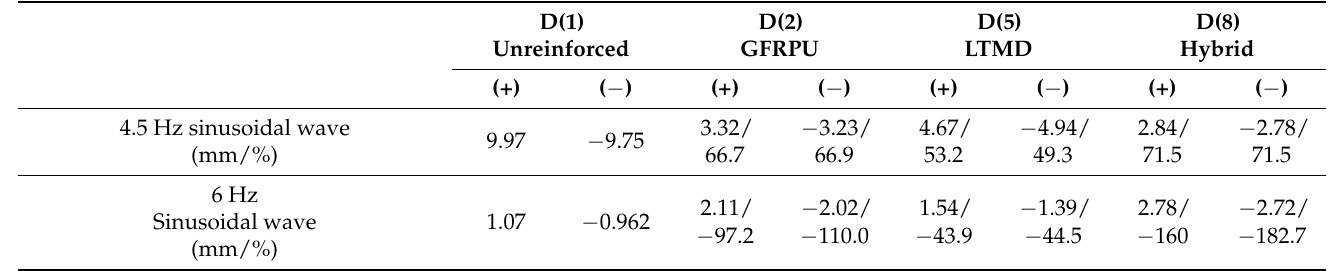
Table 5. Summary of dynamic responses under sinusoidal